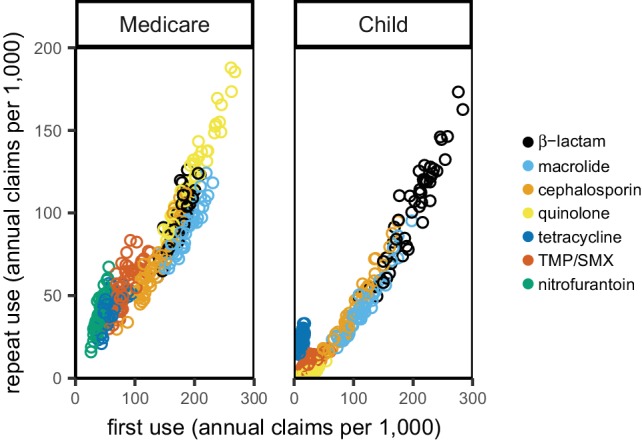
Distribution of antibiotic use by population.Each point represents average use of a drug group in a state across data years. Children: MarketScan data including only members 15 and younger.